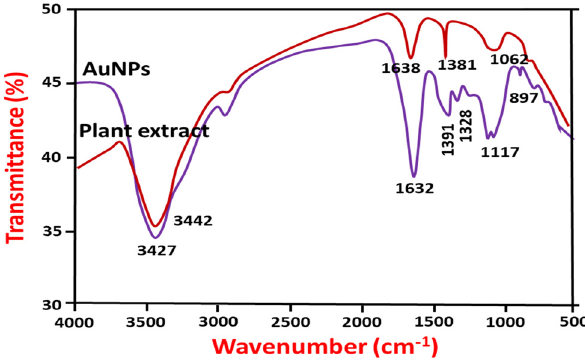
Figure 5: FTIR spectrum of AuNPs and plant extract.